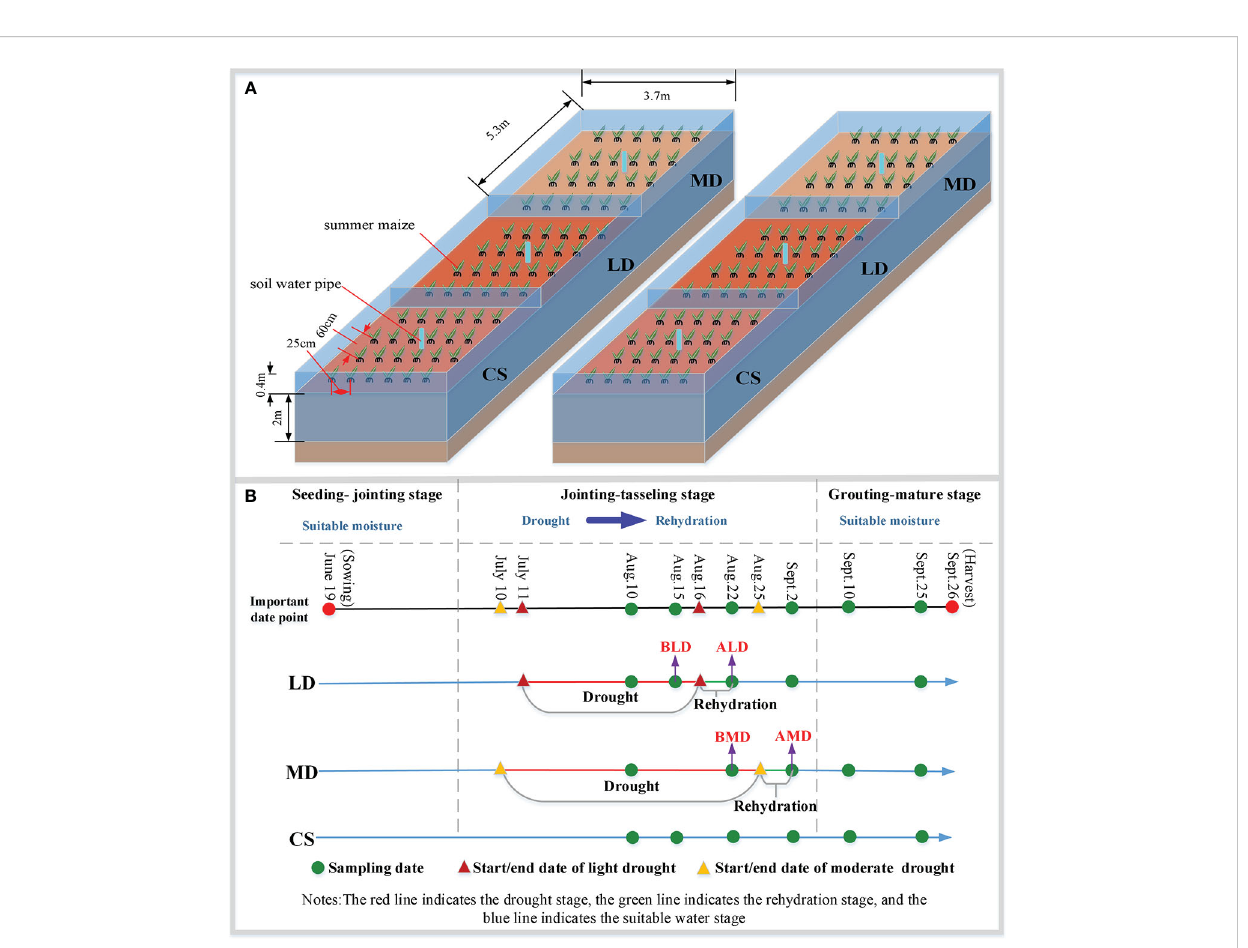
FIGURE 1 Design diagram of the experimental scheme. (A) is the design diagram of the experimental fi eld; (B) is a simpli fi ed diagram of drought- level experimental